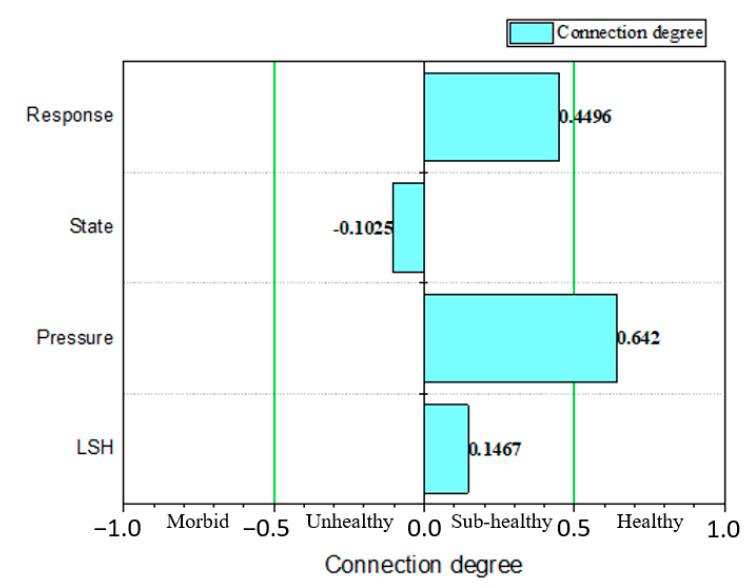
Figure 3. Connection degree of the assessment standards and assessment indices.